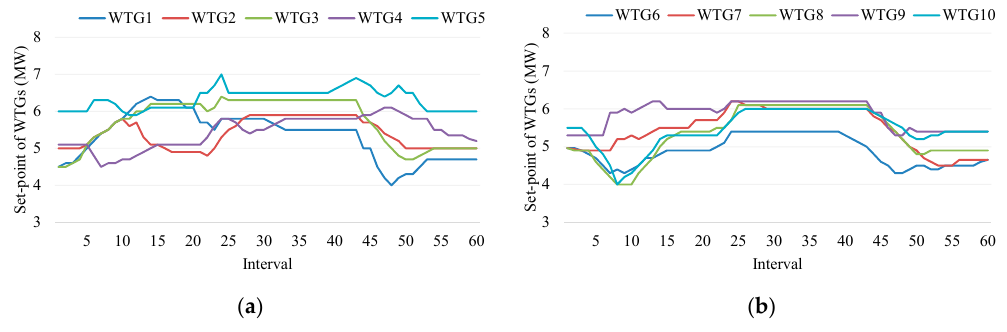
Figure 13. Optimal set-points of WTGs in WF: ( a ) Cluster 1; ( b ) Cluster 2.